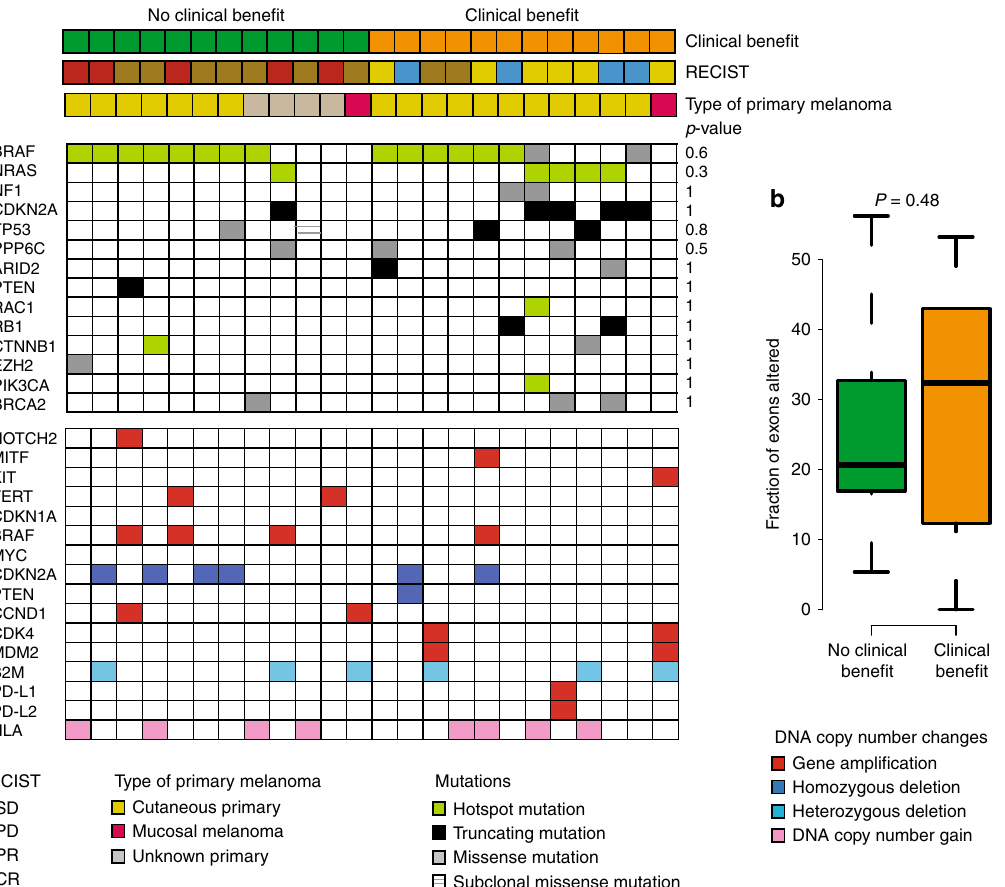
Fig. 3 Driver gene mutations and copy number aberrations are not associated with clinical bene fi t of ACT in melanoma a . Mutations in melanoma driver genes in tumors from patients without (left) and with (right) clinical bene fi t from ACT. There is no signi fi cant difference in mutation frequency between the groups in any of the genes, as shown on the right by the P -values from logistic regression with adjustment for mutational load of samples. b Fraction of exons with copy number changes for tumors from patients with and without clinical bene fi t. P -value from Mann – Whitney test. In this standard boxplot, the center line represents the median, the box limits represent the lower and upper quartiles, the whiskers extend to the most extreme values within 1.5xIQR. RECIST categories: CR complete response; PD progressive disease; PR partial response; SD stable